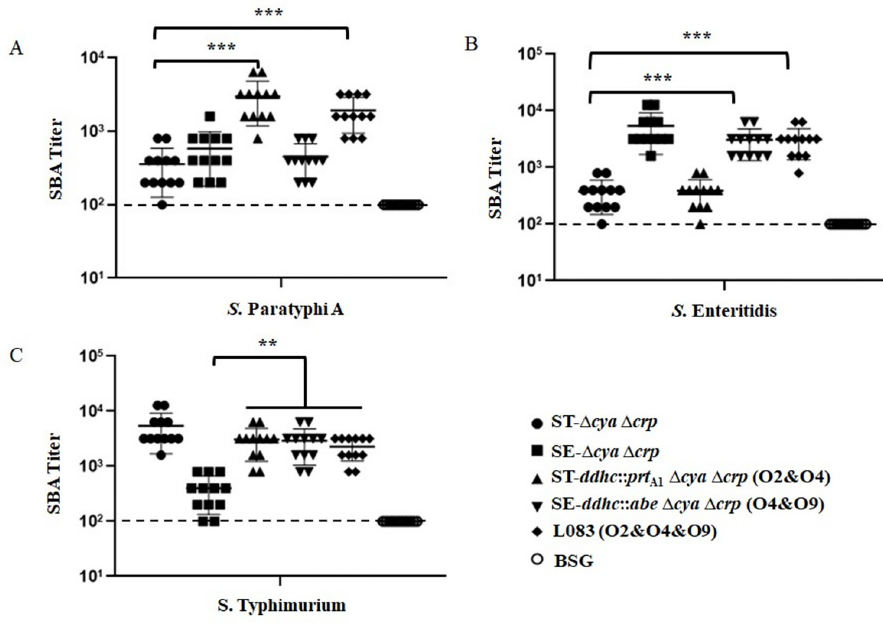
Fig 7. Serum bactericidal activity. Serum bactericidal assays (SBA) were performed with vaccinated mouse serum from the indicated groups against wild-type S . Paratyphi A (A), S . Enteritidis (B) and S . Typhimurium (C). Strains were grown in LB to log phase (OD 600 , 0.4). The error bars represent the standard deviation of the mean titers calculated by GraphPad Prism software. The dashed lines indicate the detection limit of the assay. �� , P < 0.01; ��� , P <